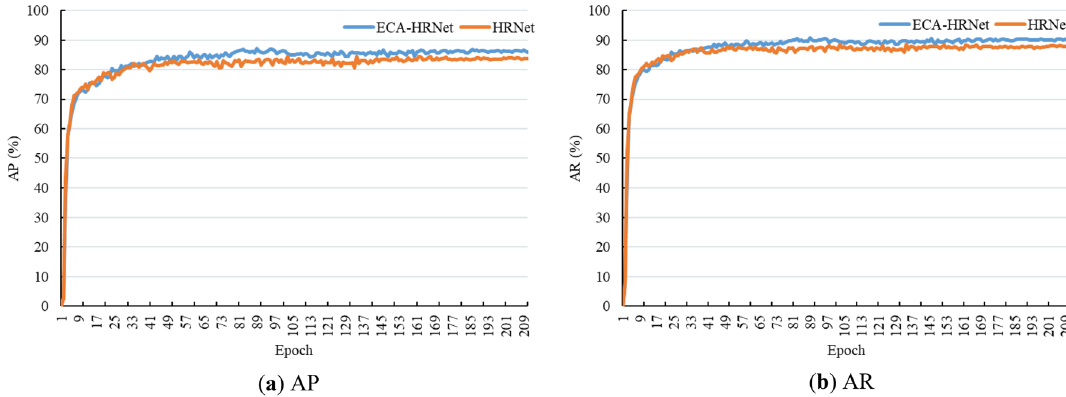
Figure 9. AP and AR curves for HRNet and ECA-HRNet.